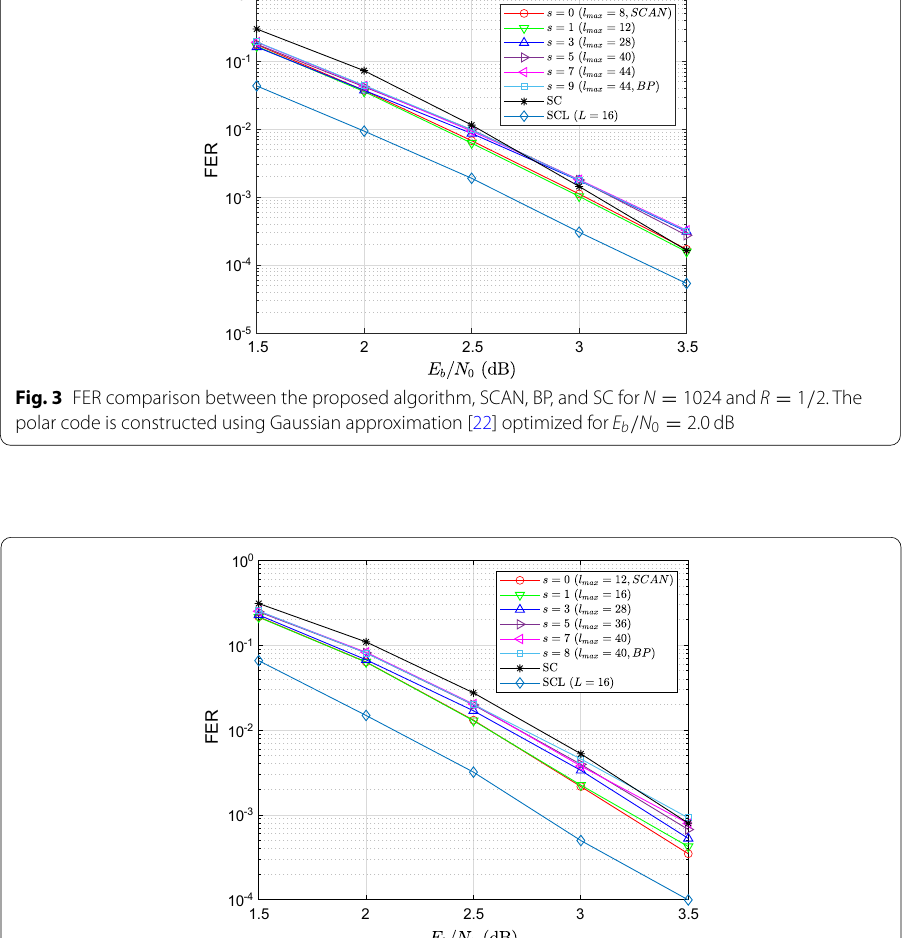
Fig. 4 FER comparison between the proposed algorithm, SCAN, BP, and SC for N polar code is constructed using Gaussian approximation [22] optimized for E b / N